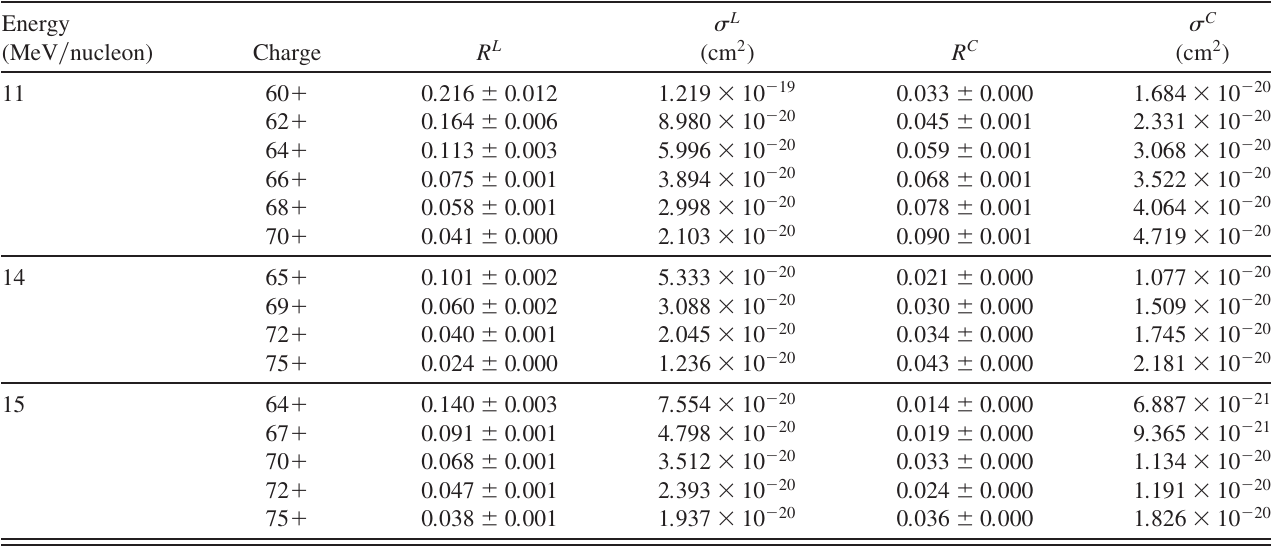
TABLE III. Experimental data on the cross sections of e-loss ( (cid:2) L ) and e-capture ( (cid:2) C ) and the reaction rates of e-loss ( R L ) and e-capture ( R C ) for each charge of uranium beam in the energies of 11, 14, and 15 MeV = nucleon .